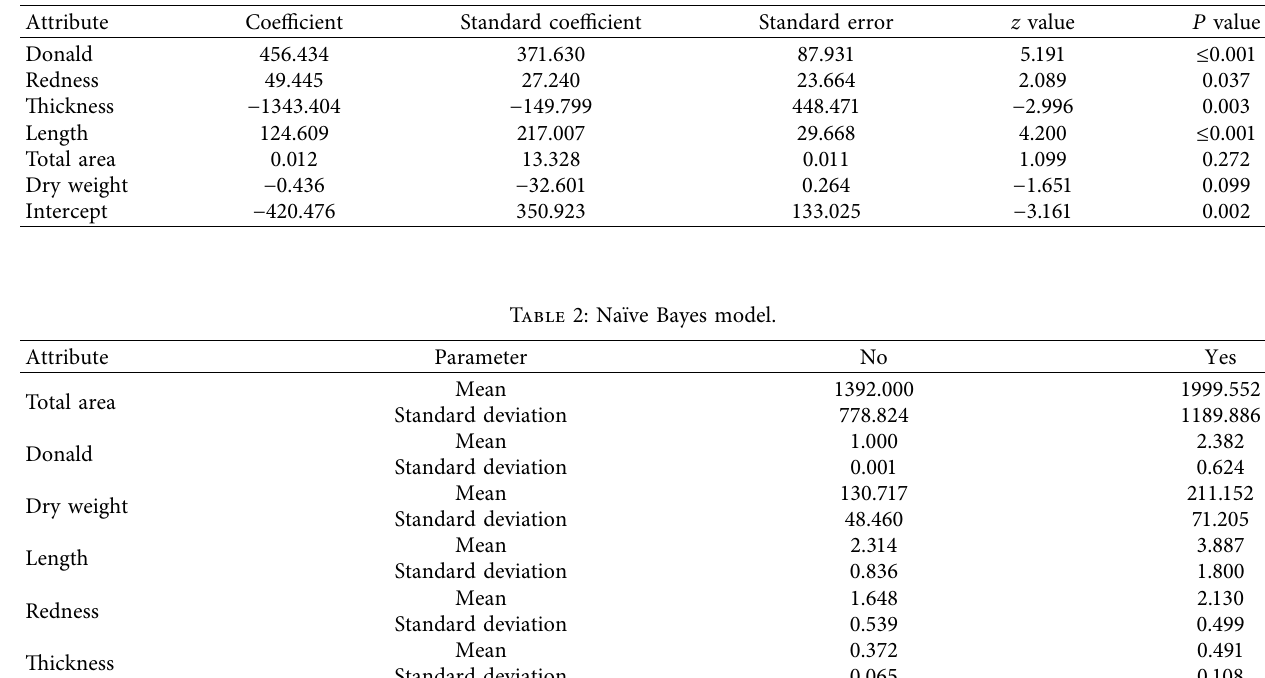
Table 1: Logistic regression model.